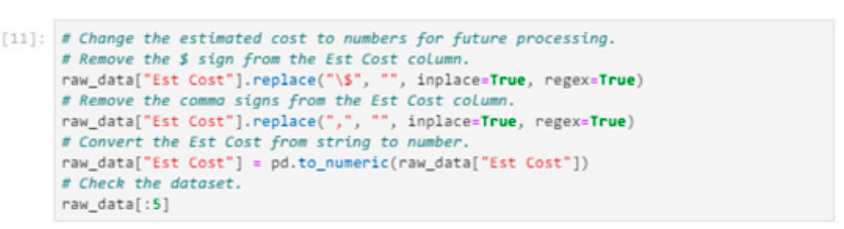
Figure 10. Sample code fixing unnecessary characters.